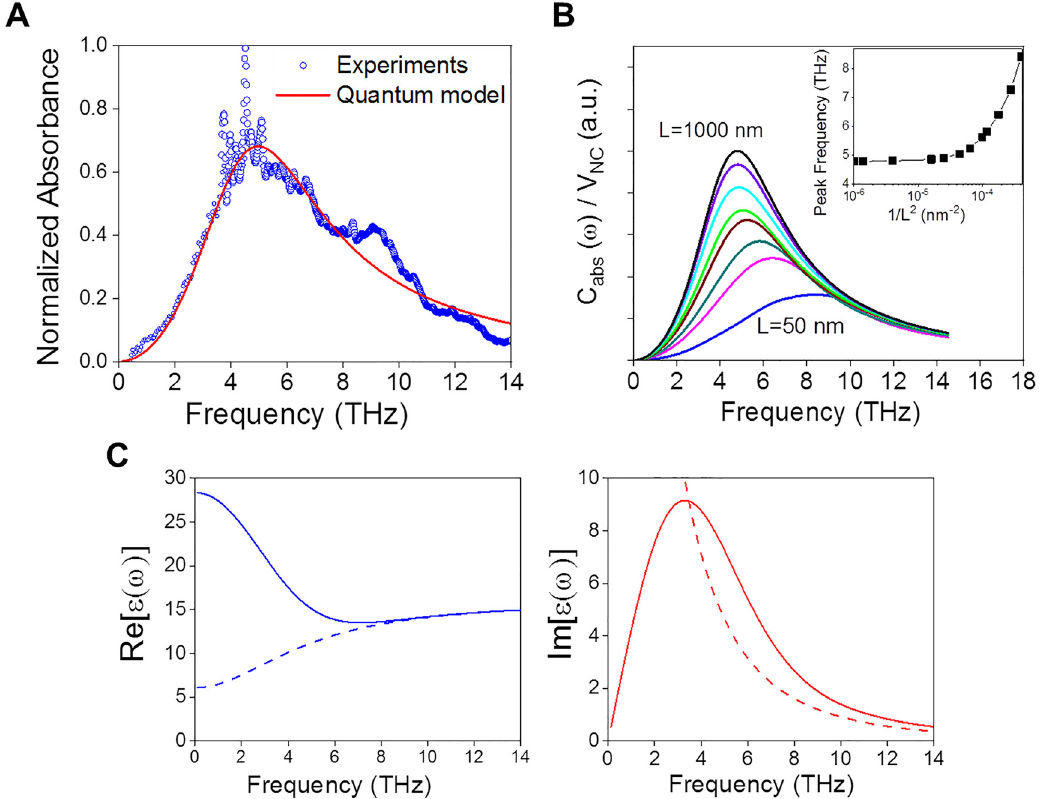
Figure3: (A)Calculationsbasedonthefullquantum-mechanicalmodelofthenormalizedabsorbanceofthecompositefilm, A ( ω )(redline),for achemicalpotential μ =8meV,abroadeningof γ =10meV,asizedistributionreportedinFigureS4andexperimentaldataobtainedfromTHz- TDS and FTIR measurements (blue dots). (B) The absorption cross-section per unit volume of individual NCs, C abs ( ω ; L ) / V NC , for NC sizes rangingfrom L =1000nmto L =50nm,assuming μ =8meVand γ =10meV.Inset:Peakfrequencyof C abs ( ω ; L ) asafunctionof1/ L 2 insemi-log scale re fl ecting more quantum con fi nement of carriers as NCs become smaller. (C) Real, Re [ ϵ ( ω )] , and imaginary parts, Im [ ϵ ( ω )] , of the intrabandpermittivityasafunctionofthephotonfrequency,foraHgTeNCofsize L =92nm, µ =8meVand γ =10meV.Forcomparison,dashed curves are the real and imaginary parts of the permittivity based on classical Drude